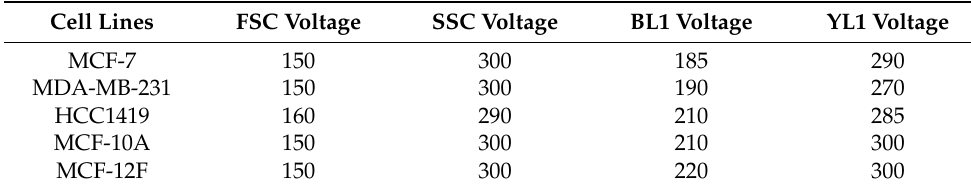
Table 1. Flow cytometry channel voltages in each cell line. Cell